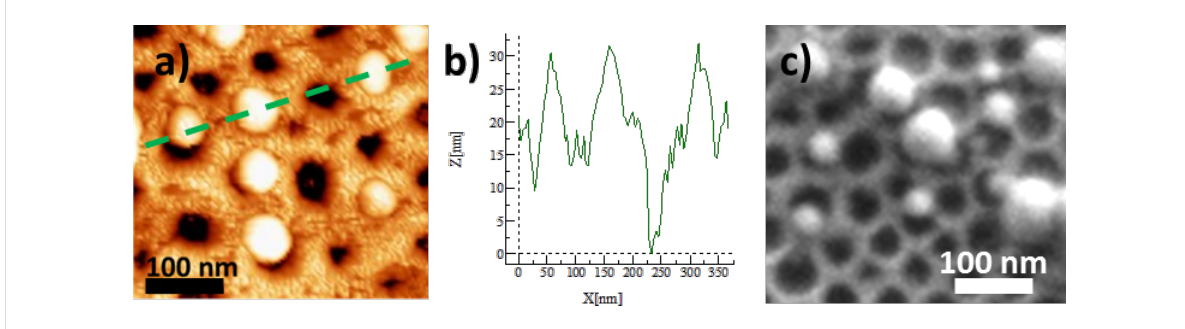
Figure 8: a) AFM image, b) height profile along the green dotted line on the AFM image and c) SEM image of NC01 .